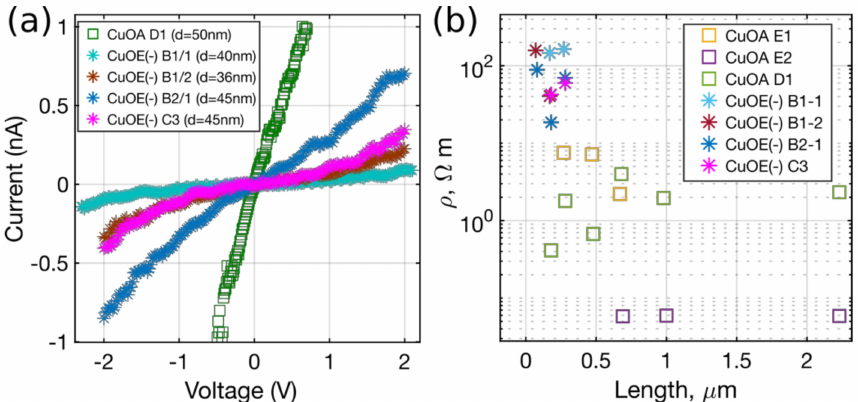
Figure 7. ( a ) IVCs of the CuO nanowires grown via two di ff erent approaches; ( b ) calculated resistivities ρ of CuO nanowires shown as a function of the measured nanowire length